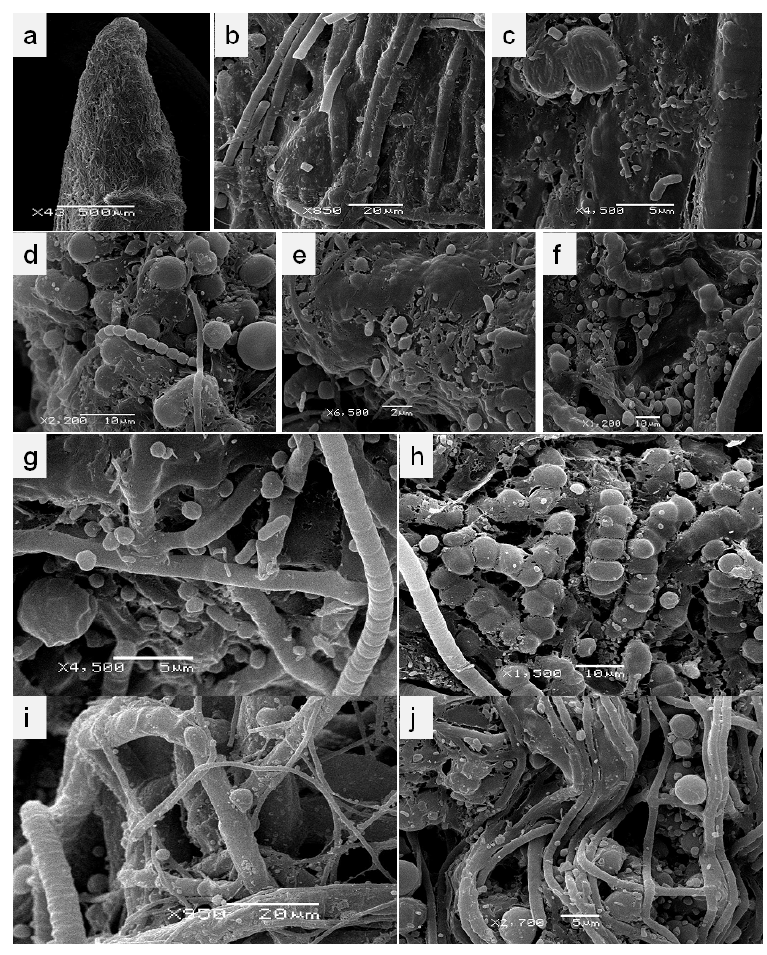
Figure 2. The scanning electron micrographs of Microcoelia moreauae ( a – c , g , h ) and Chiloschista parishii ( d – f , i , j ) roots in the enrichment culture in liquid BG N ( a – f ) and BG 0 ( g – j ) media. Cyanobacterial community covering the root tip ( a – c ); filamentous non-heterocyst-forming trichomes of cyanobacteria forming biofilms with the help of the extracellular matrix, and bacterial cells anchored within this biofilm. Filaments, arranged in clusters, thin and straight without evident branching, observed in BG N and BG 0 media on the roots of both orchids. The description corresponds to the Leptolyngbyaceae family, which was confirmed by denaturing gradient gel electrophoresis (DGGE) and sequencing (Section 3.2). Filamentous unbranched isolates with division in multiple planes, formed of spherical to barrel-shaped cells, were abundantly present under nitrogen-limiting conditions on the roots of C. parishii ( j ).